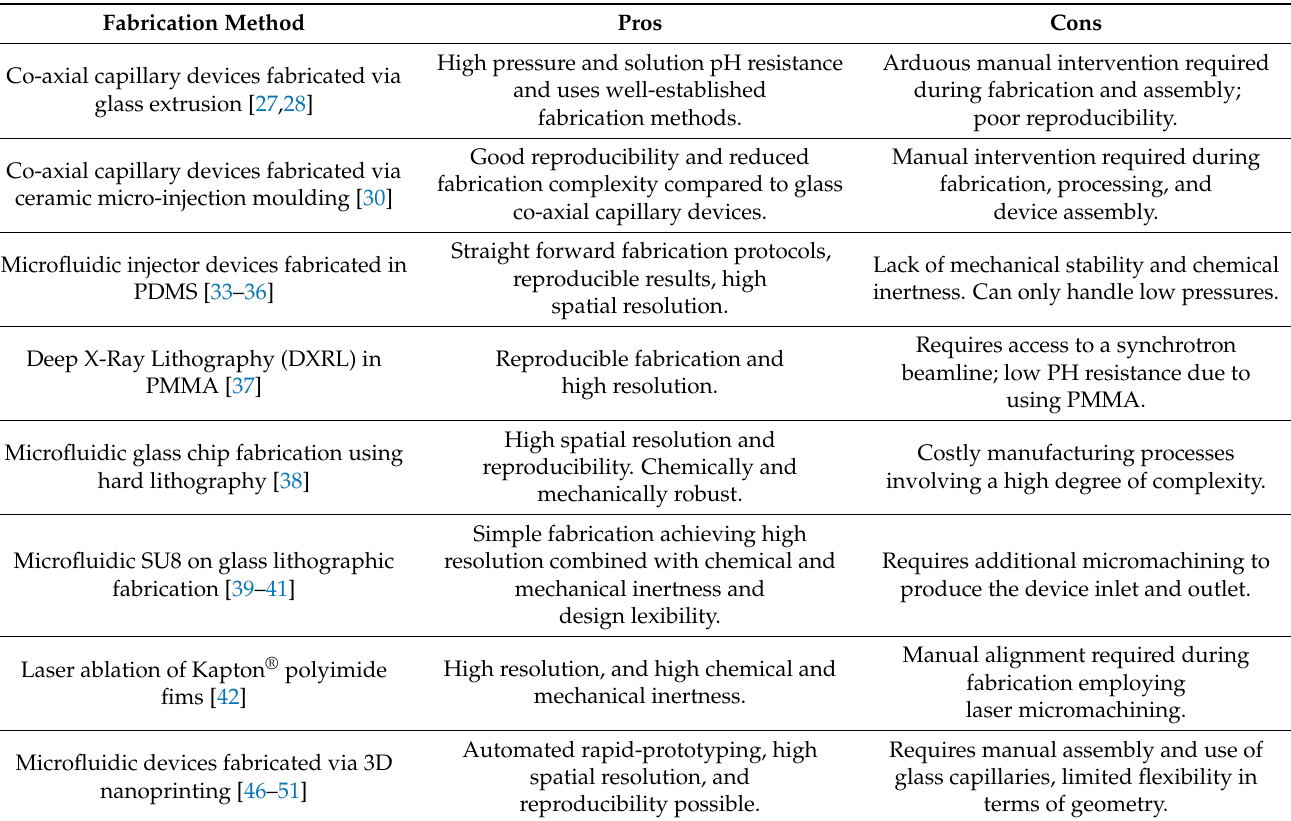
Table 1. Summary of fabrication methods (see Section 3) along with their pros and